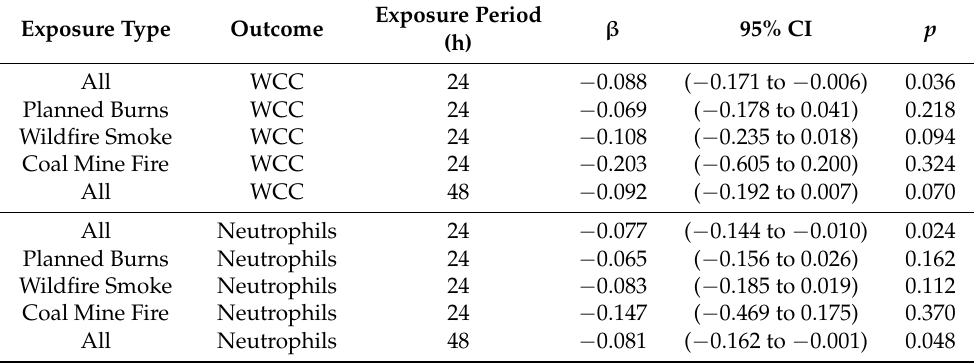
Table 4. Changes in total white cell count (WCC) and neutrophil counts Regression coefficients ( β ) and 95% confidence intervals per 10 µ g/m 3 PM 2.5 adjusted for temperature, humidity, smoking status, asthma diagnosis and